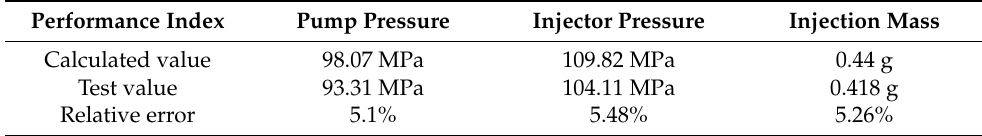
Table 2. Fuel injection system calculation and test data.